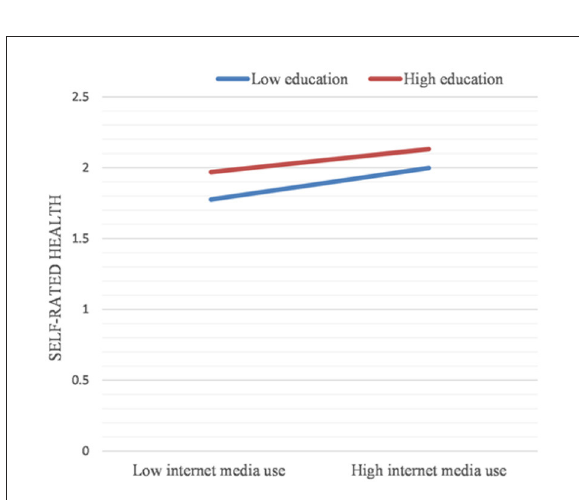
FIGURE2 Simple slope plot for the interaction between internet media use and education (Dependent variables: Self-rated health).